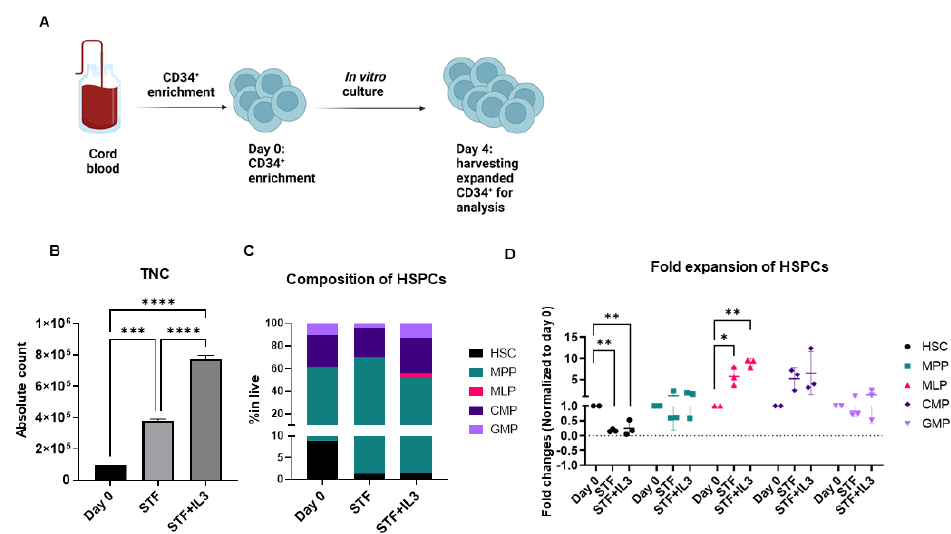
Figure 1. Human CD34 + cells were expanded in cytokine-supplemented medium: ( A ) Schematic experimental design. ( B ) Total Nucleated Cells (TNC) increased between three- and eightfold in presence of cytokine after 4 days of culture ( n = 3, *** p < 0.001, **** p < 0.0001, one-way Anova). ( C ) Stacked bar graph shows composition of Hematopoietic Stem cells and Progenitors (HSPCs) on day 0 (after enrichment) and after 4 days of culture with the indicated cytokine cocktails. ( D ) Dot plot shows fold changes of expanded HSPCs on day 4 compared to day 0. ( n = 3, * p < 0.05, ** p < 0.01, one-way